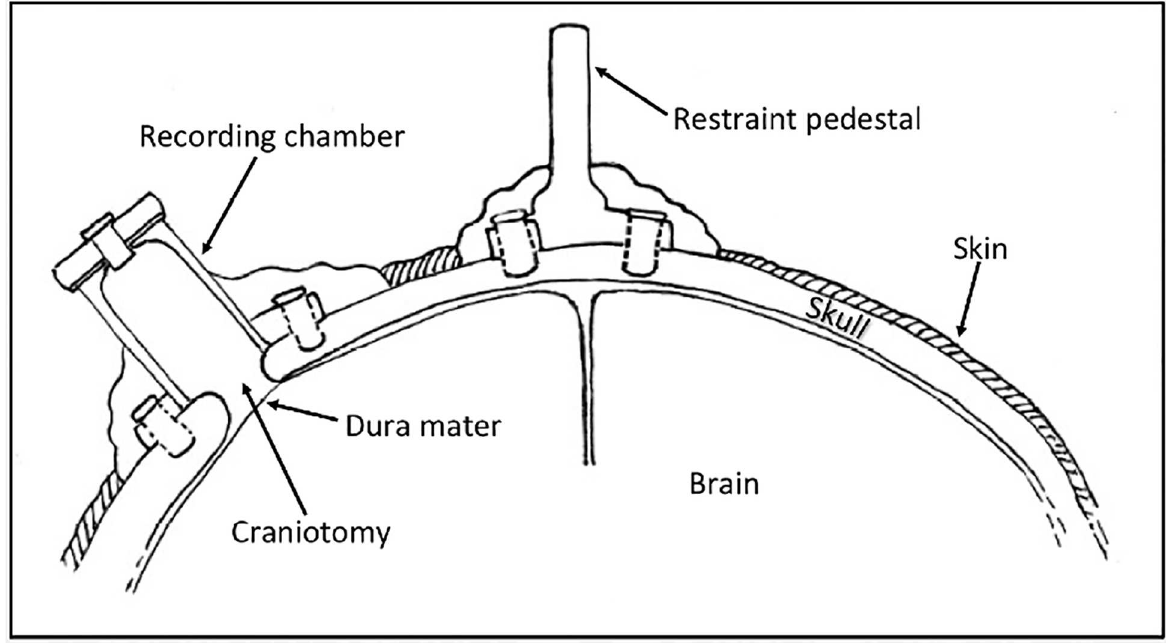
Fig 1. Illustration of Cephalic Implants Used for Neuroscience Research. Cephalicrecordingchambers and restraint pedestalsare commonly affixed to the skull using a combination of screws and polymethyl methacrylate acrylic or other